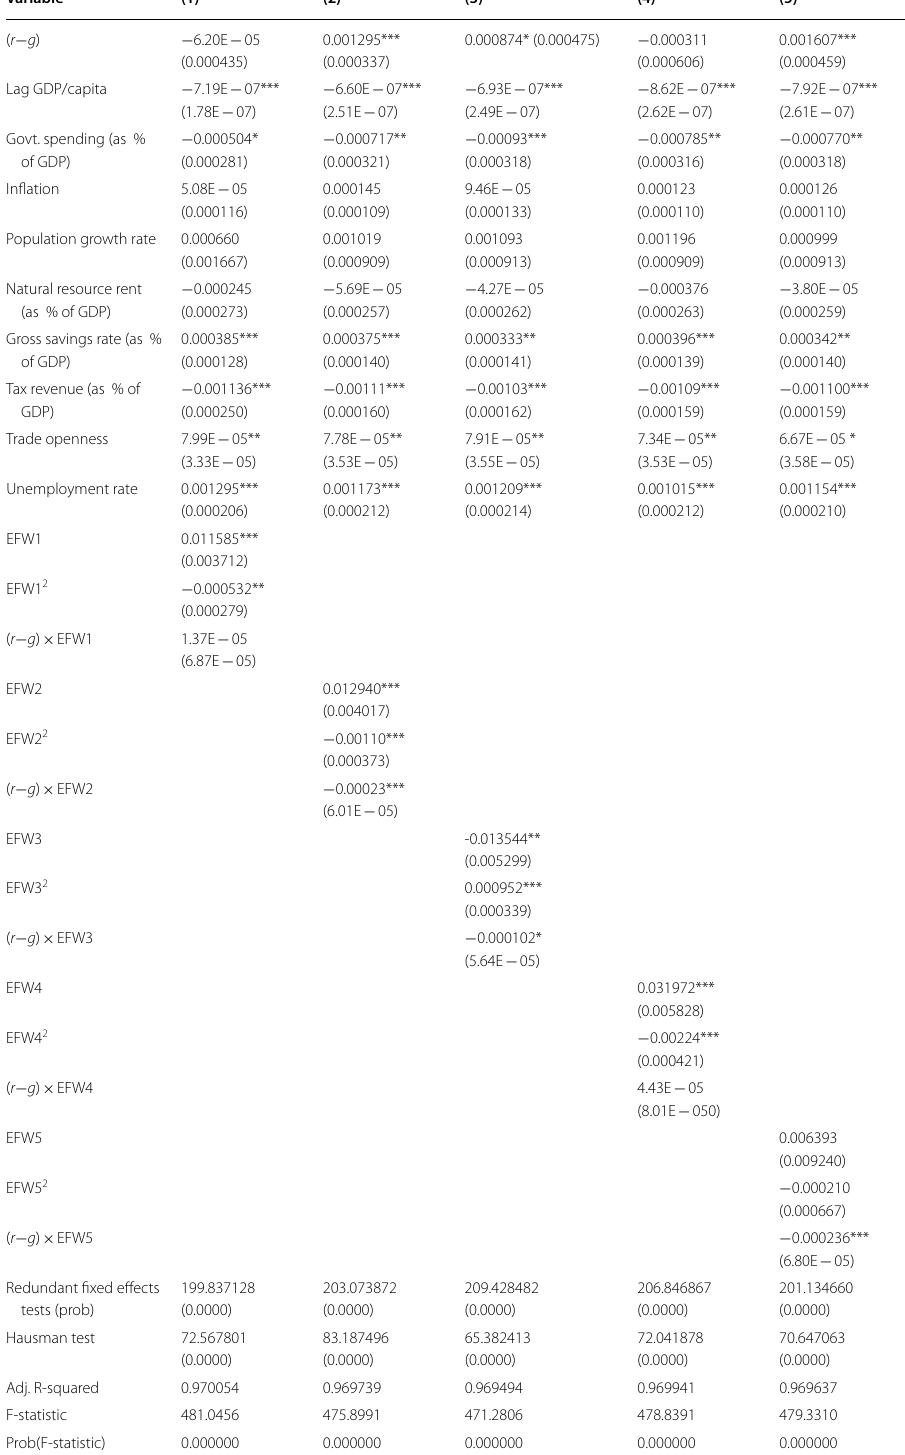
Table 7 Fixed effect estimation results of five areas of economic